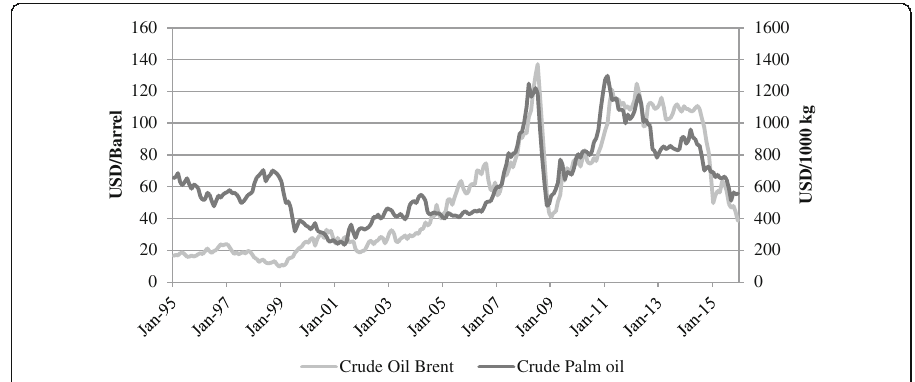
Table 1 Descriptive statistics of log returns from January 1995 till December 2015 1995 – 2005 (monthly log returns) EU butter Oceania butter Crude palm oil Crude oil Brent